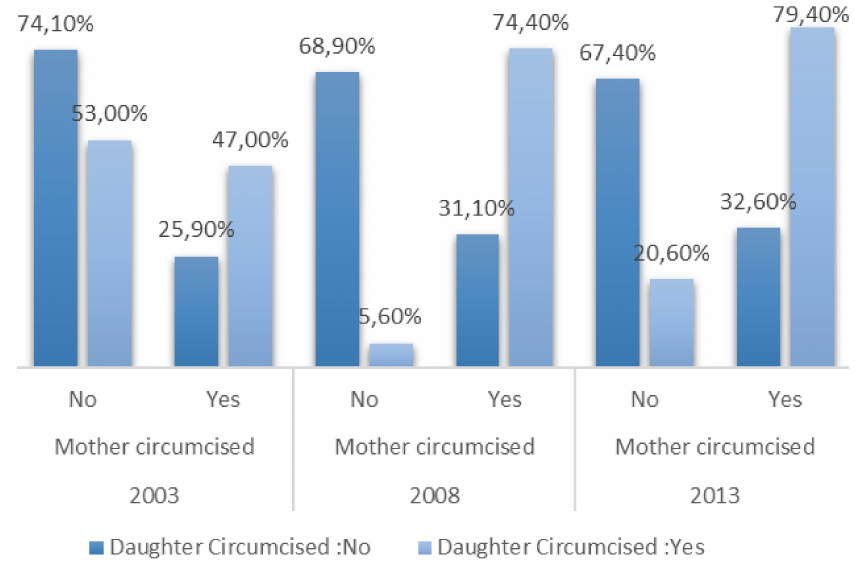
Figure 1. Prevalence of female genital mutilation (FGM) among daughters stratified by FGM status of mothers. (“,” represents